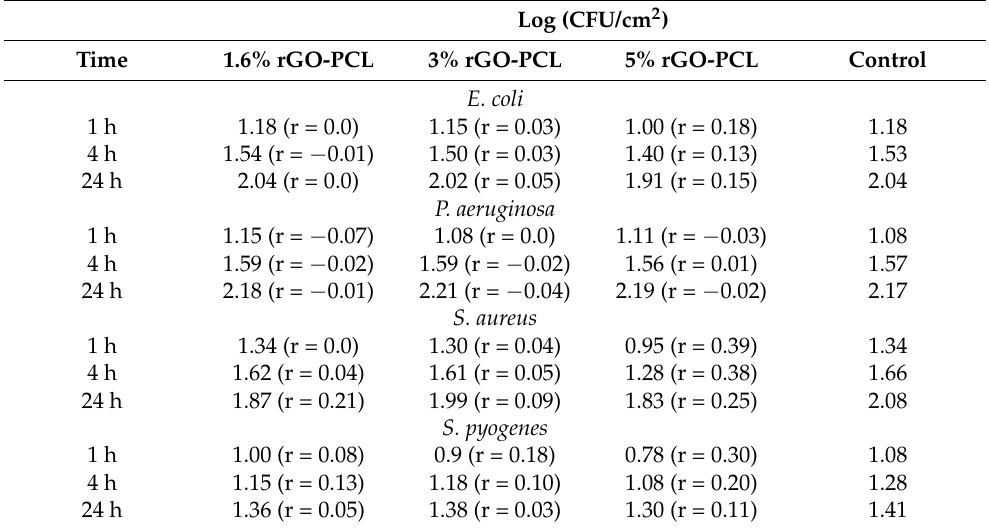
Table 2. Colony forming units (CFU) of E. coli , P. aeruginosa , S. aureus , and S. pyogenes after seeding on 1.6% rGO-PCL, 3% rGO-PCL, and 5% rGO-PCL for 1, 4, and 24